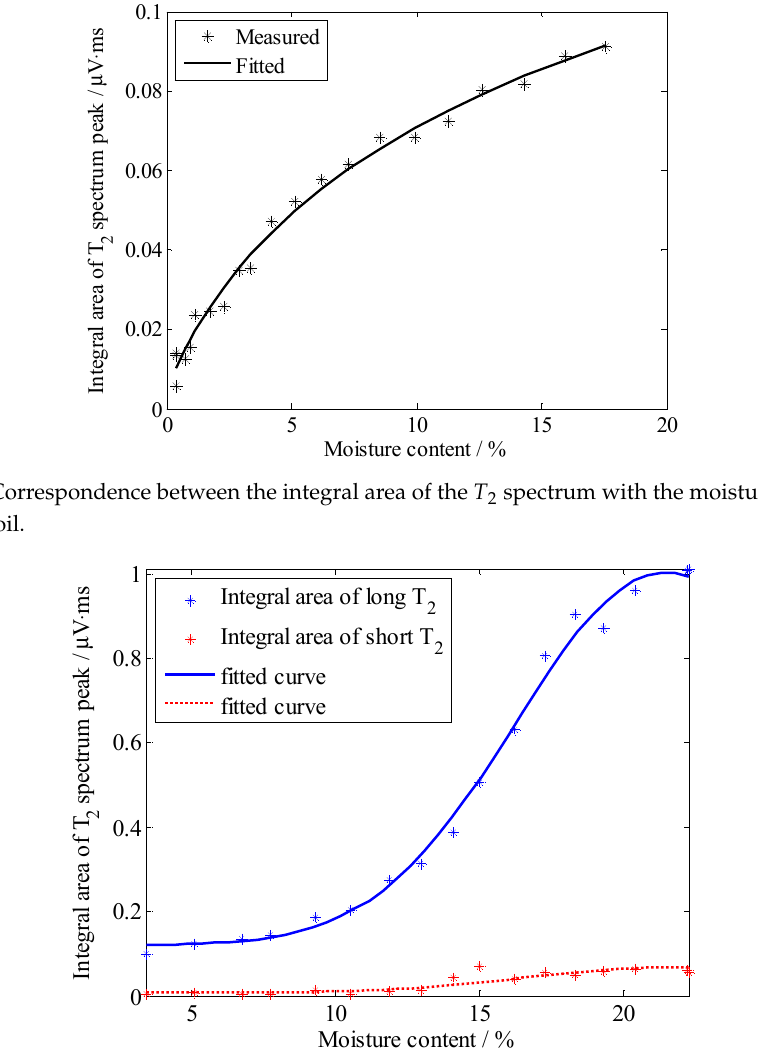
Figure 14. Correspondence between the integral area of the T 2 spectrum with the moisture content of the silica sand.